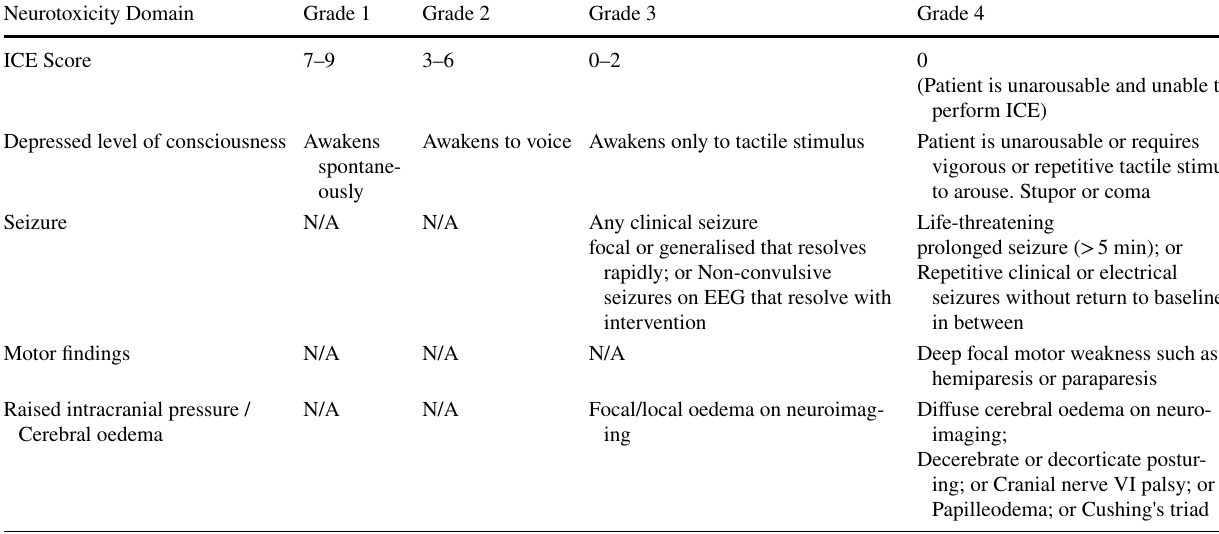
Table 3 Grading of neurotoxicity as per ASTCT consensus guidelines